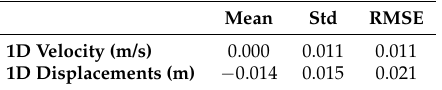
Table 3. RMSEs for residual 1D velocity and displacements.